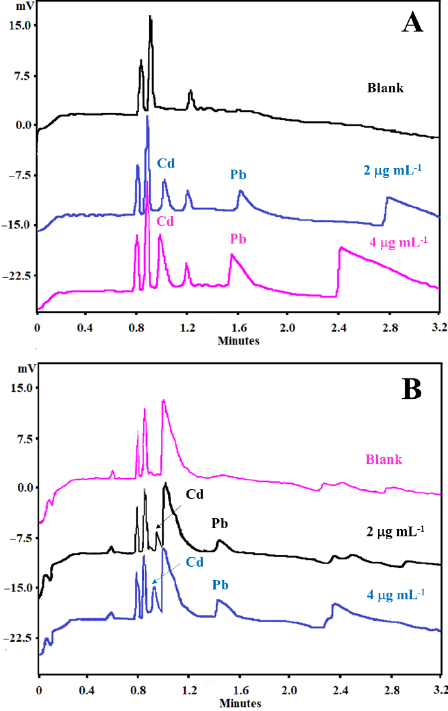
Figure 4. Electropherograms of Cd 2+ and Pb 2+ standards at 2 and 4 µg mL −1 spiked in ( A ) ultrapure water (black line, blank; blue line, 2 µg mL −1 ; pink line, 4 µg mL −1 ) and ( B ) Passiflora incarnata tea samples (pink line, blank; black line, 2 µg mL −1 ; blue line, 4 µg mL −1 ). Conditions: indirect mode, 12.2 cm effective length, 50 cm full-length capillary, BGE with 5 mmol L −1 imidazole, 6 mmol L −1 HIBA, 32.5 mmol L −1 18-crown-6, 3.8% methanol, temperature at 20 °C, hydrodynamic short-end injection (0.5 psi by 5 s), and detection at 214 nm.